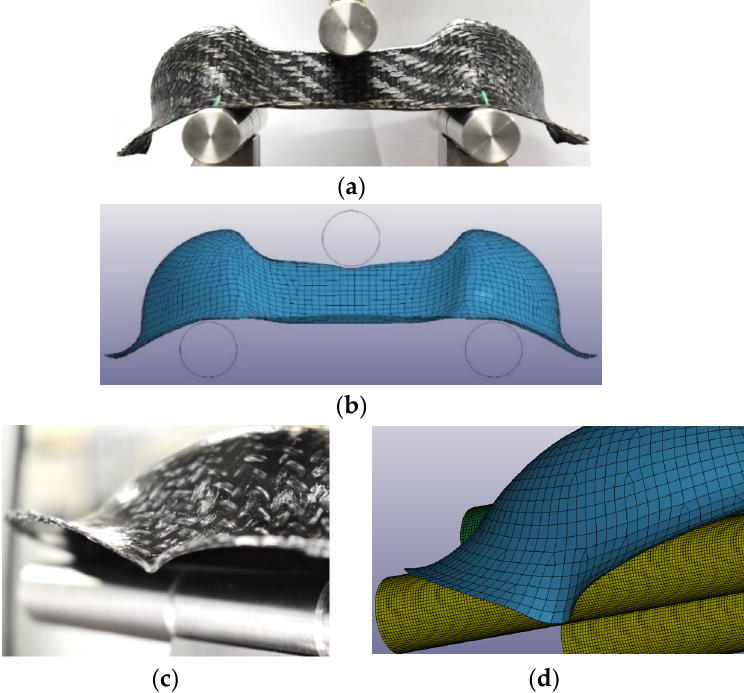
Figure 32. Experimental–FEA visual comparison during the three-point bending test on the GF/PP Double Dome: global view ( a , b ) and a detail on the bases of the dome ( c , d ).